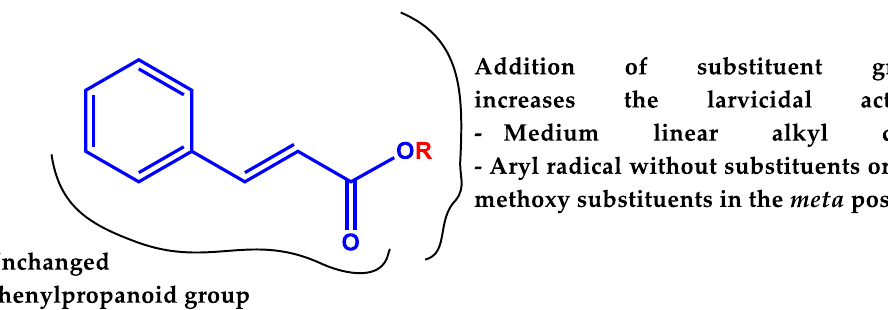
Figure 2. Structure – activity relationship ( SAR) of cinnamic acid derivatives for larvicidal activity. Figure 2. Structure–activity relationship (SAR) of cinnamic acid derivatives for larvicidal